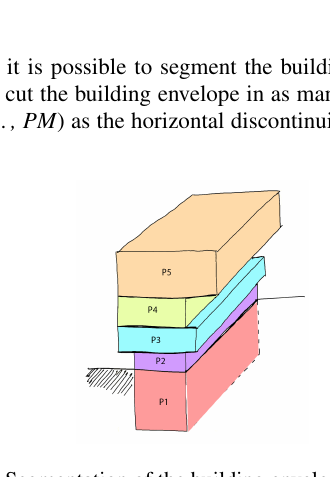
Figure 8. Segmentation of the building envelope according to the horizontal discontinuities.